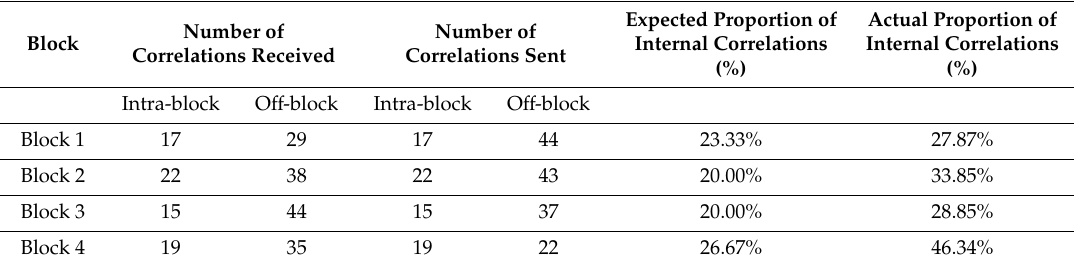
Table 3. Characteristics of each block in the spatial network of health resource aggregation capacities in China in